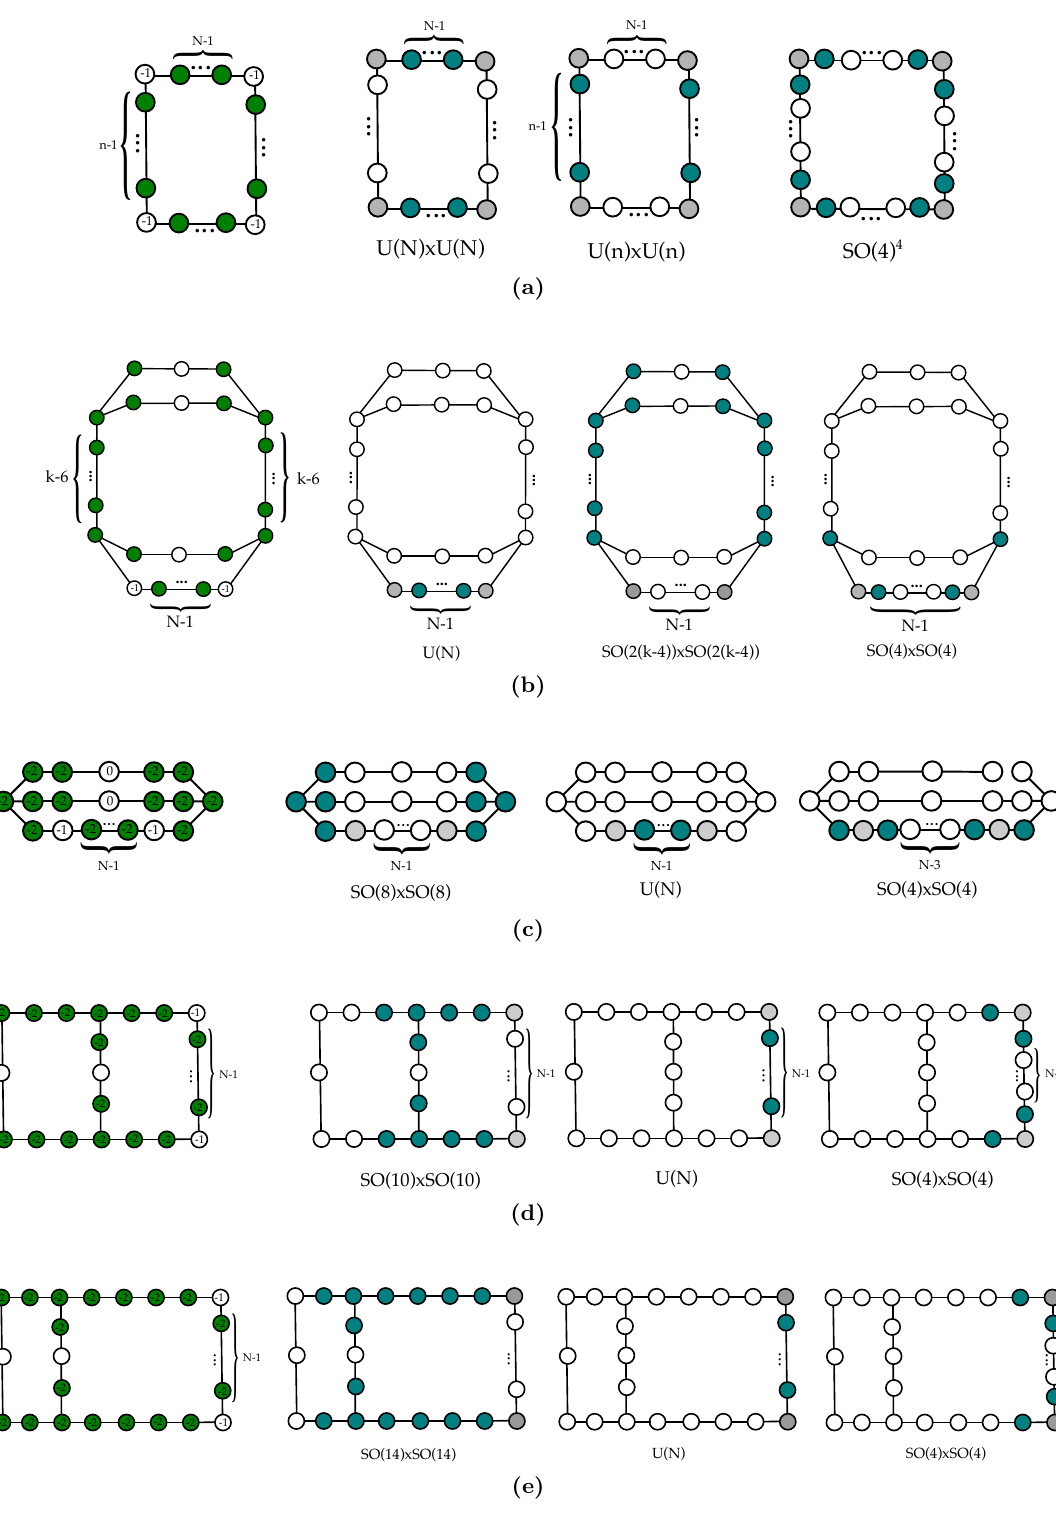
Figure 5. CFDs (on the l.h.s.) of tables 5 and 6 and the embeddable BG-CFDs. Below the BG-CFDS we note the classical (cid:13)avor symmetry.